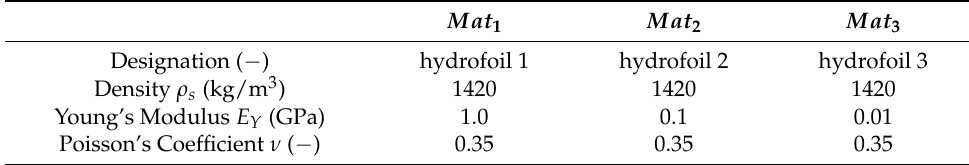
Table 1. Mechanical characteristics of the hydrofoil material for the domain Ω TE